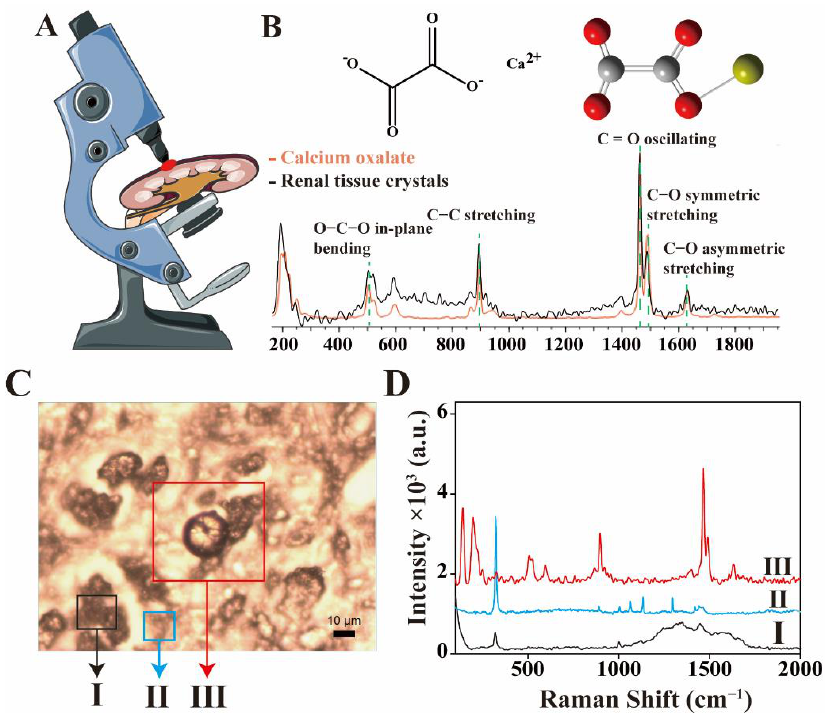
Figure 2. ( A ) Schematic diagram of Raman detection of crystals. ( B ) The measured data were compared with the database of HORIBA and the crystals were calcium oxalate dihydrate. ( C ) Bright field image of a tissue section, the part of kidney tissues (I), the part of paraffin (II) and the part of calcium oxalate dihydrate crystals (III) (magnification 500 × ). ( D ) Raman spectral data corresponding to ( C